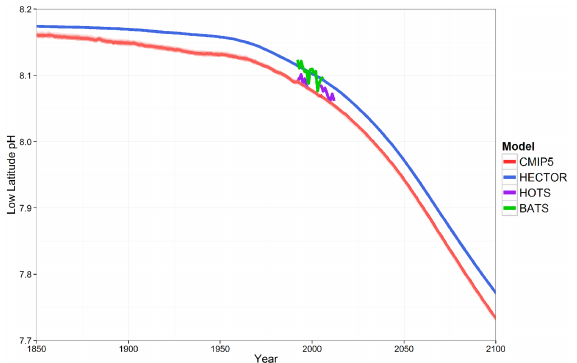
Figure 11. Low-latitude (<55) ocean pH for RCP 8.5, from 1850 to 2100, Hector (blue), CMIP5 median, standard deviation, and model range (pink, n = 6); and observations from BATS (green) and HOTS